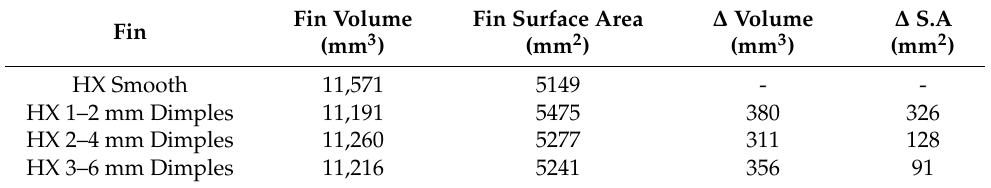
Table 2. Smooth vs. dimpled fins’ mechanical properties.